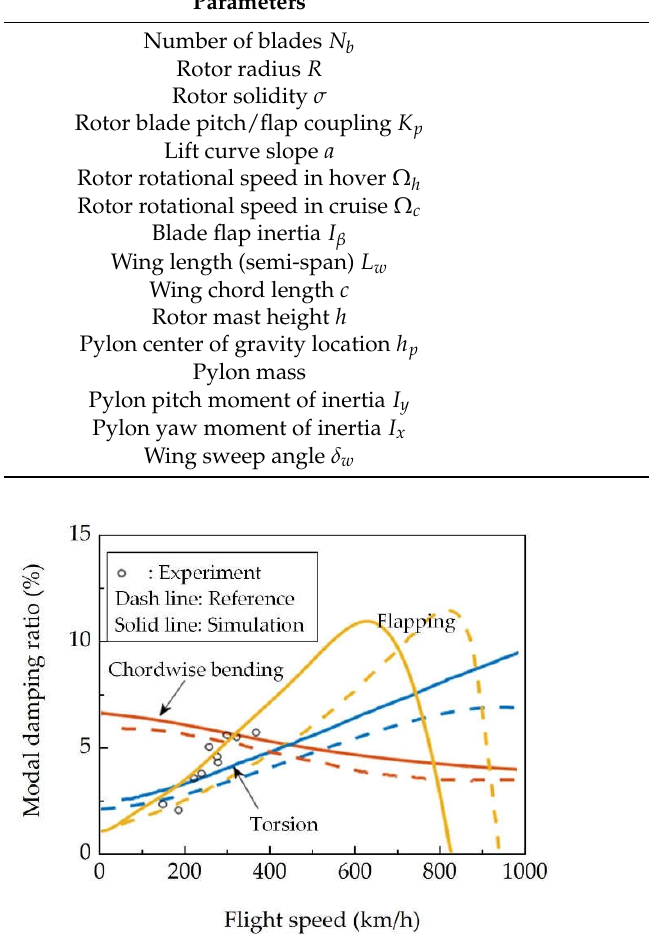
Figure 3. Variation of wing modal damping ratio with cruise speed.